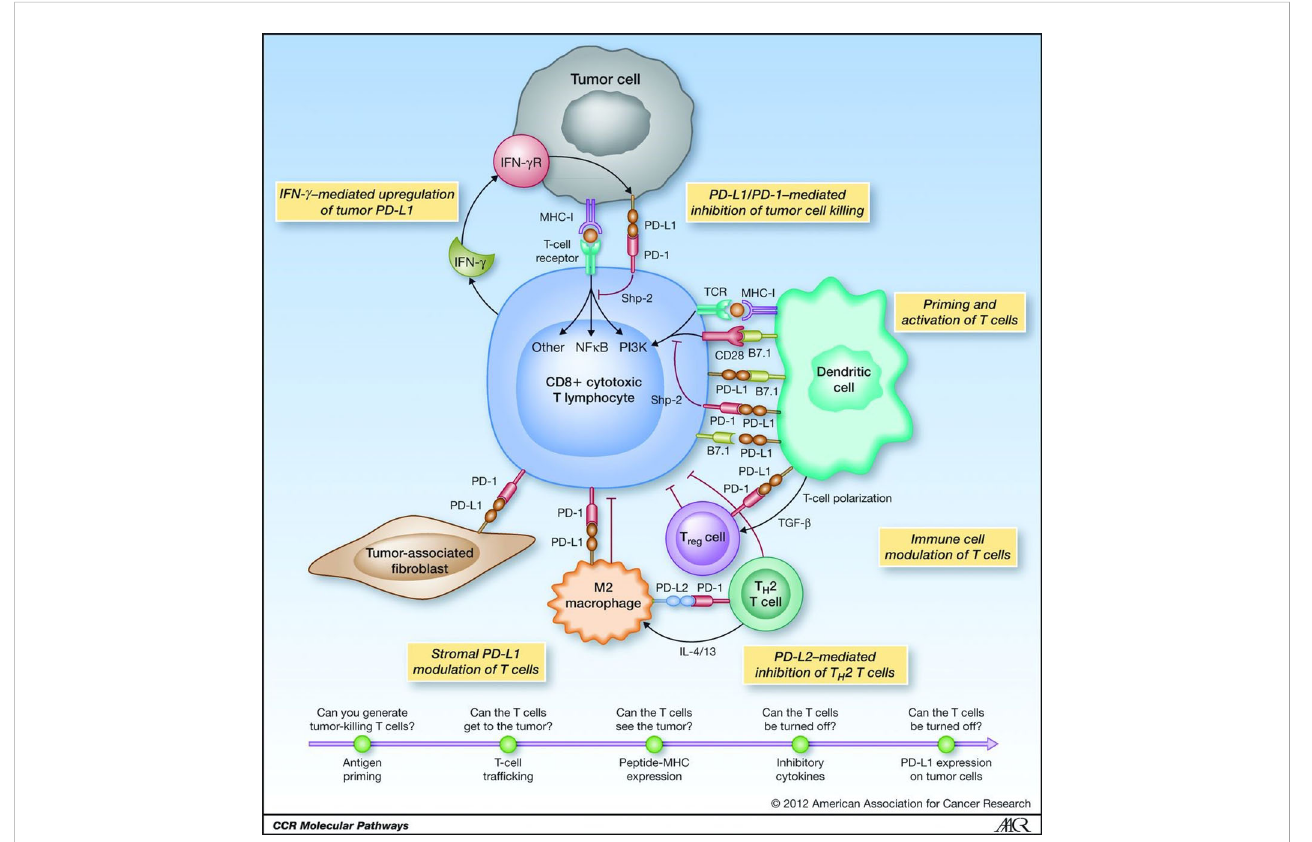
FIGURE 2 Tumor immunology and the PD-L1/PD-1